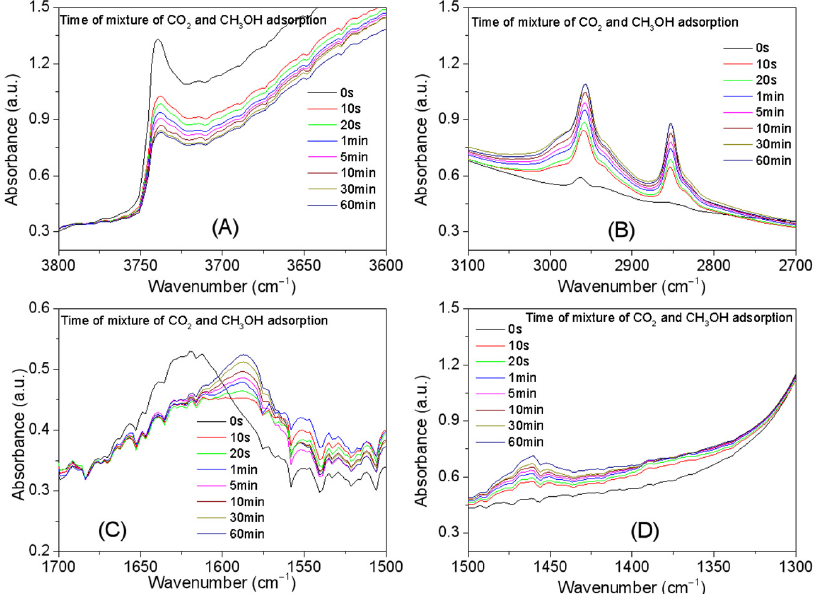
Figure 8. Infrared spectra of the co-adsorption of CH 3 OH and CO 2 over Zr/SBA-15 in the regions of 3800 cm − 1 –3600 cm − 1 ( A ), infrared spectra of the co-adsorption of CH 3 OH and CO 2 over Zr/SBA-15 in the regions of 2700 cm − 1 –3100 cm − 1 ( B ), infrared spectra of the co-adsorption of CH 3 OH and CO 2 over Zr/SBA-15 in the regions of 1500 cm − 1 –1700 cm − 1 ( C ), infrared spectra of the co-adsorption of CH 3 OH and CO 2 over Zr/SBA-15 in the regions of 1300 cm − 1 –1500 cm − 1 ( D ).